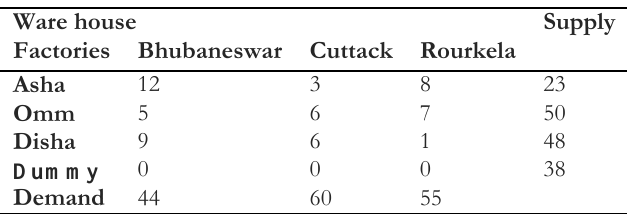
Table 10. Initial basic feasible solution.